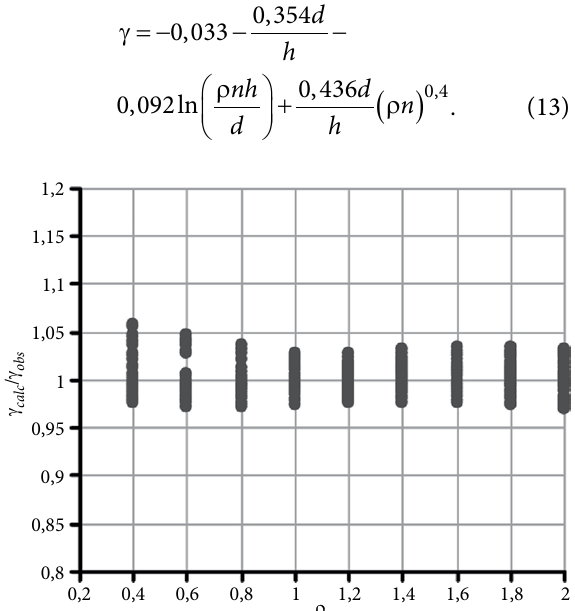
Fig. 11. γ γ / calc obs for varying reinforcement ratio